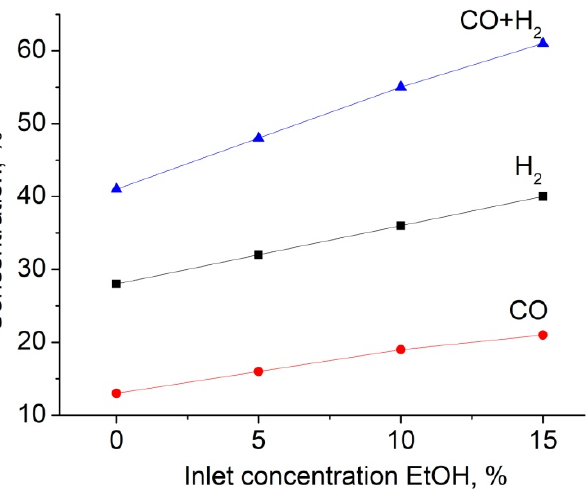
Figure 10. Dependence of products concentration on ethanol content in feed 24% NG + 16–25% O 2 + N 2 + EtOH in the process of autothermal reforming in the radial reactor with the heat exchanger.